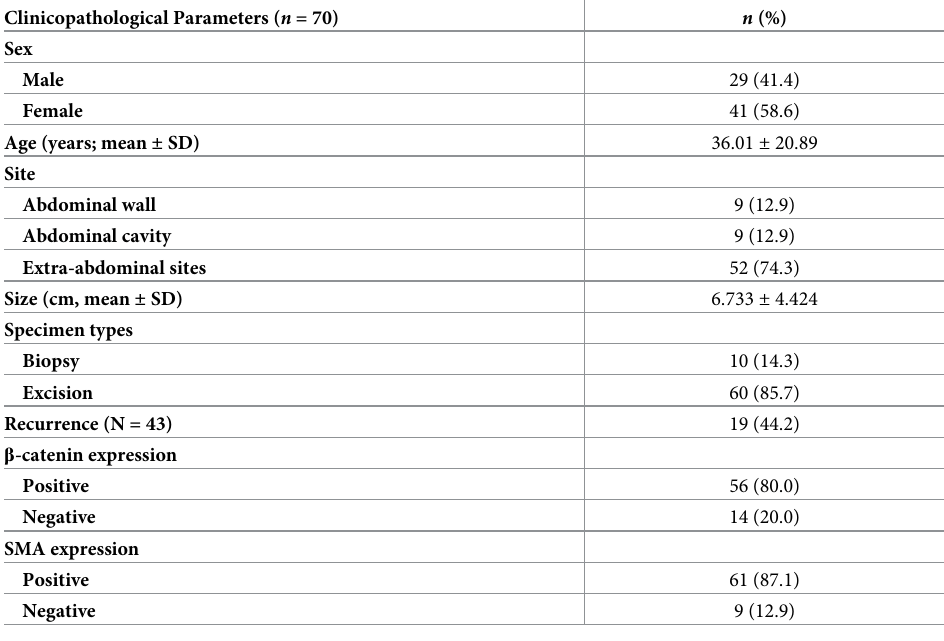
Table 1. Clinicopathological parameters in desmoid-type fibromatosis